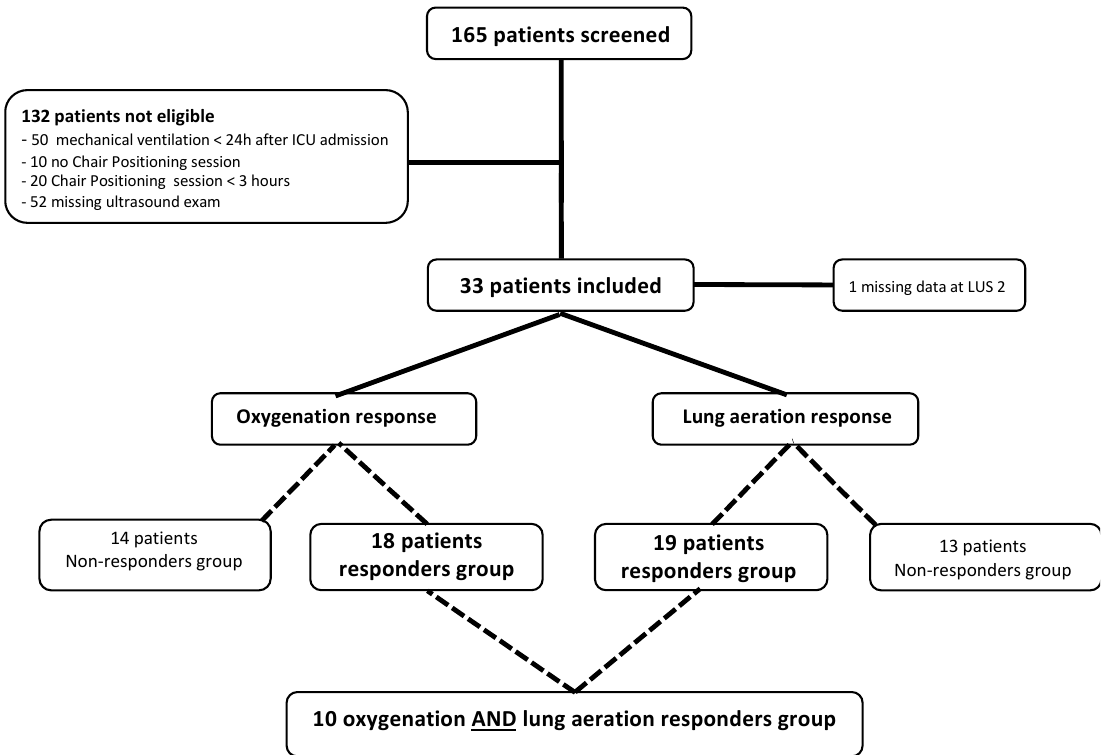
Figure 1. Flow chart of the